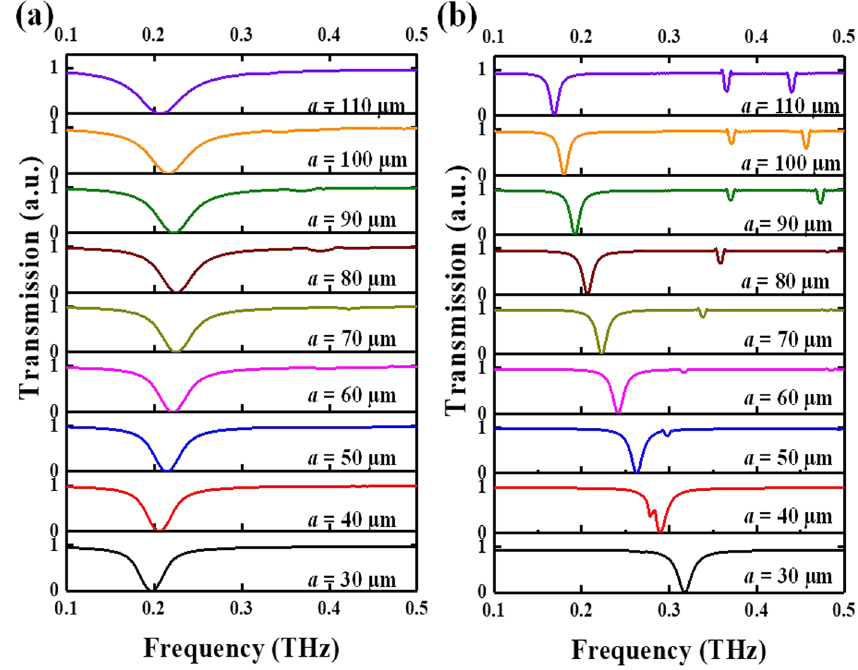
Figure 2. Simulated transmission spectra of CLM with different a value. Transmission spectra of CLM with different a value at ( a ) TE mode and ( b ) TM